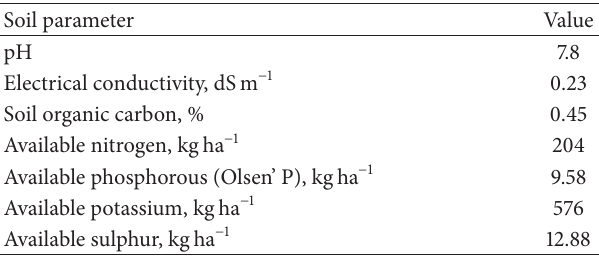
Table 1: Soil properties before the start of the